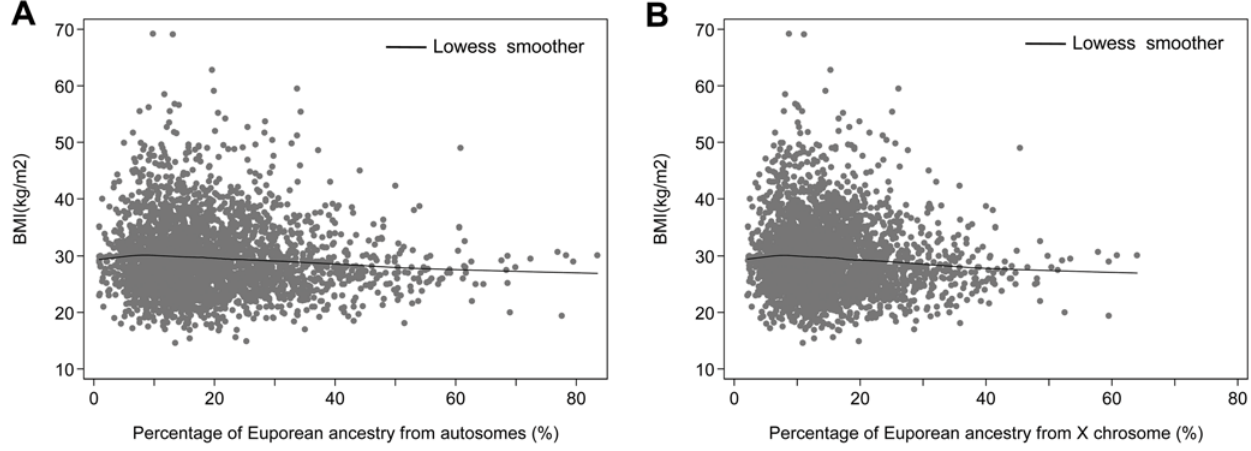
Figure 1. Scatter-plots of BMI vs. the estimated percentage of European ancestry. (A) Percentage of European ancestry was estimated based on the autosomes. (B) Percentage of European ancestry was estimated based on chromosome X. Data are plotted using 20% of the samples (selected at random) for better visualization.